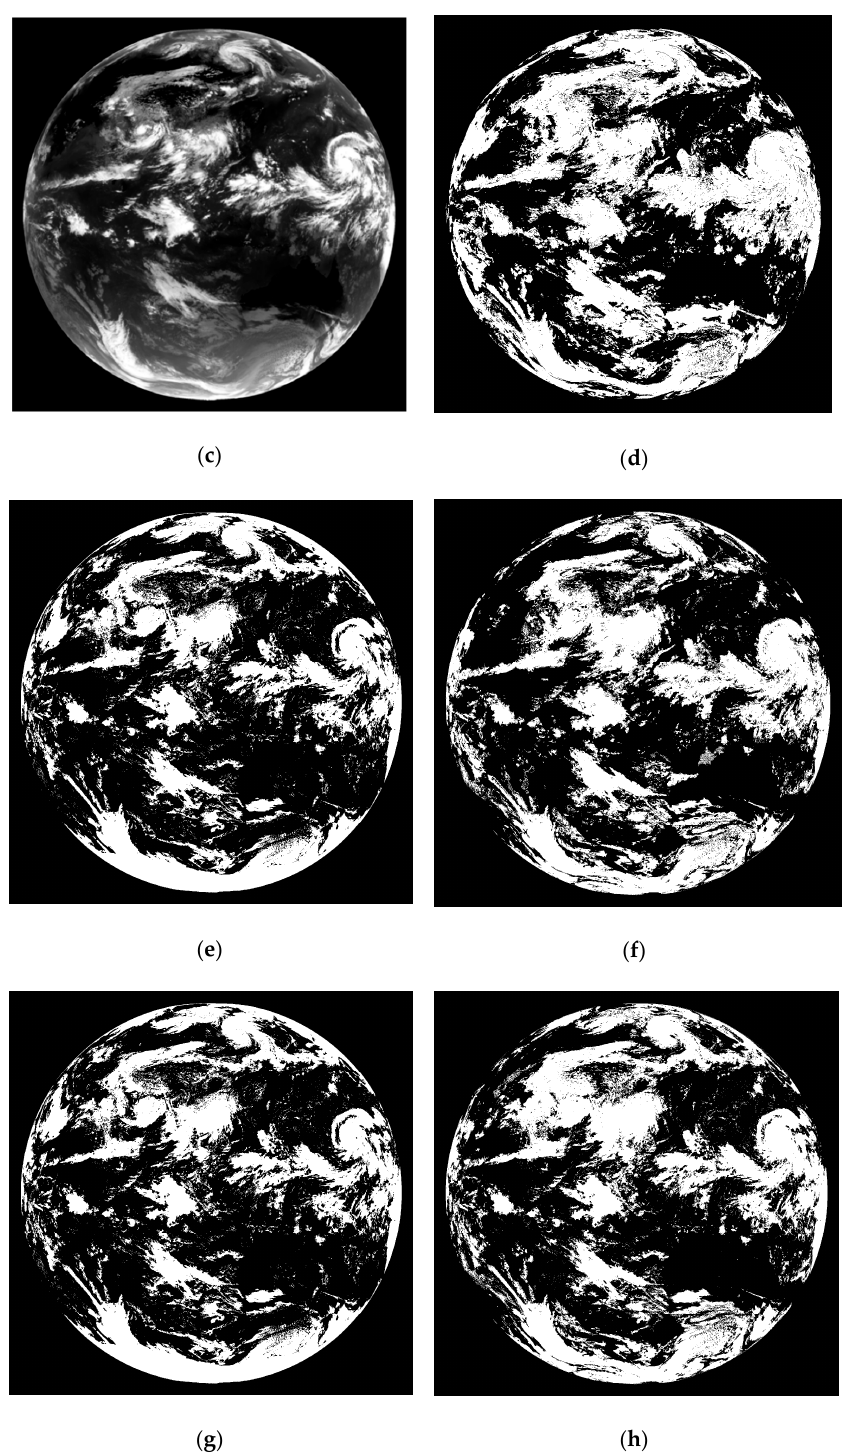
Figure 11. The cloud detection results of all employed methods at 13:00 on 2 August 2015. ( a ) Visible image; ( b ) IR1 image; ( c ) IR2 image; ( d ) NSMC cloud detection result; ( e ) Ensemble threshold result; ( f ) NSMC-RF cloud detection result; ( g ) Ensemble threshold-RF cloud detection result; ( h ) Proposed RF cloud detection result.